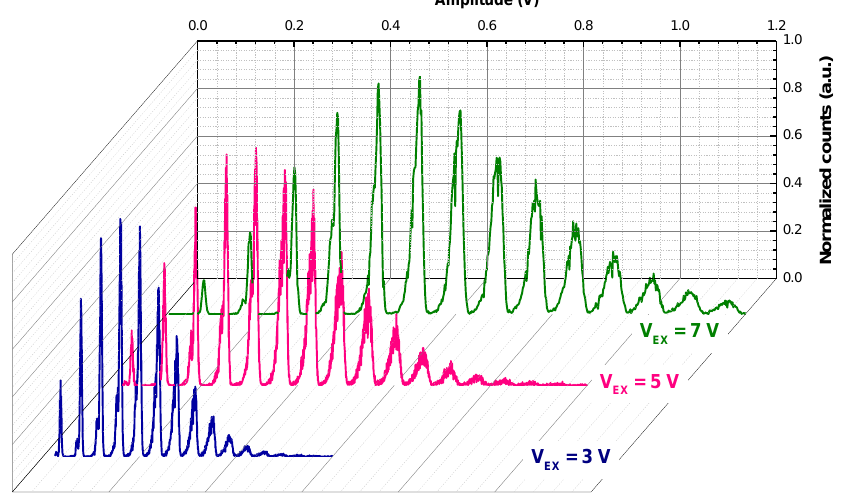
Figure 2. Pulse amplitude histogram for a deep SiPM operated at different excess bias voltages under the same illumination condition.